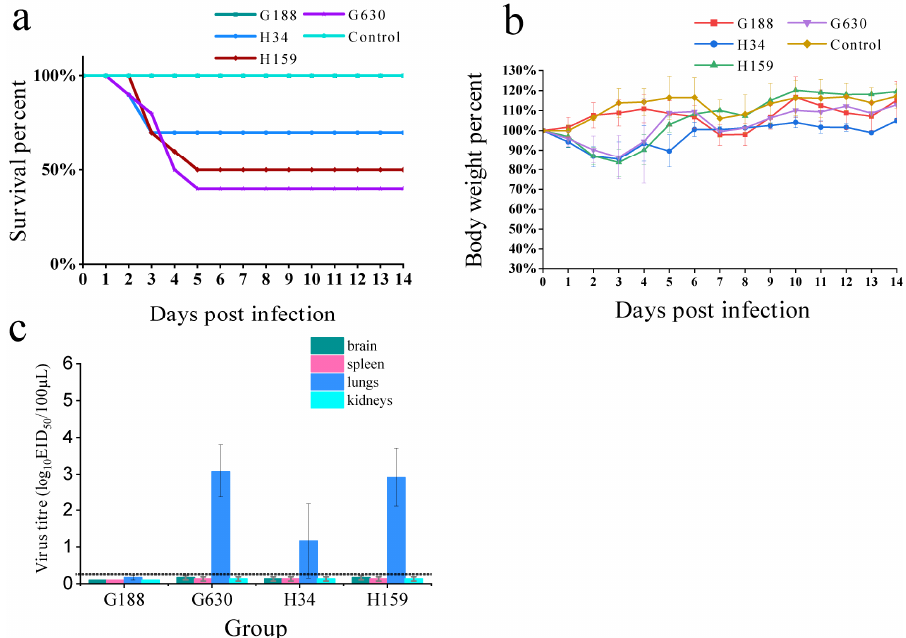
Figure 5. Five-week-old female (SPF) BALB/C-mice were inoculated with 10 6 EID 50 of the test viruses in a 50 µL volume; ( a ) survival rates of mice (mice that lost more than 20% of their body weights were regarded as dead). ( b ) Changes in body weights of mice; ( c ) horizontal dashed line indicates the lower limit of detection. Each bar represents the virus titer of the four strain replications in the brains, spleens, lungs and kidneys of infected mice.